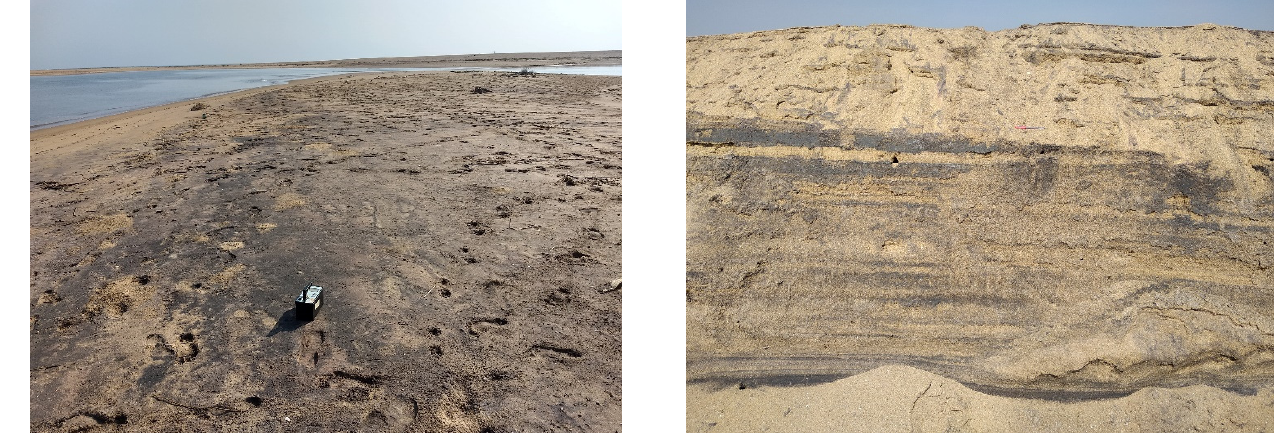
Figure 2. Field photograph with Micro R Survey Meter, which was used for radioactivity measure- ments during field work, and stratified deposits of heavy minerals from a sandy beach.